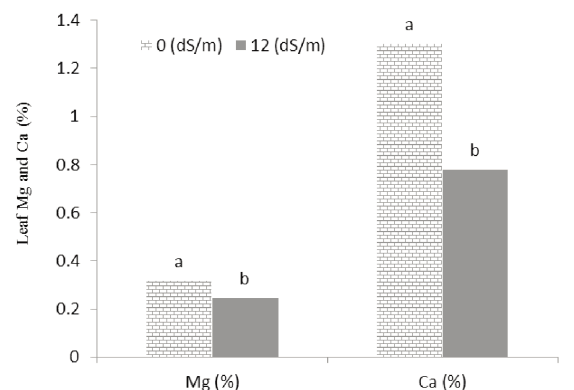
Fig. 12 ­ Effect of 12ds/m saline water treatment on leaf Mg and Ca content.